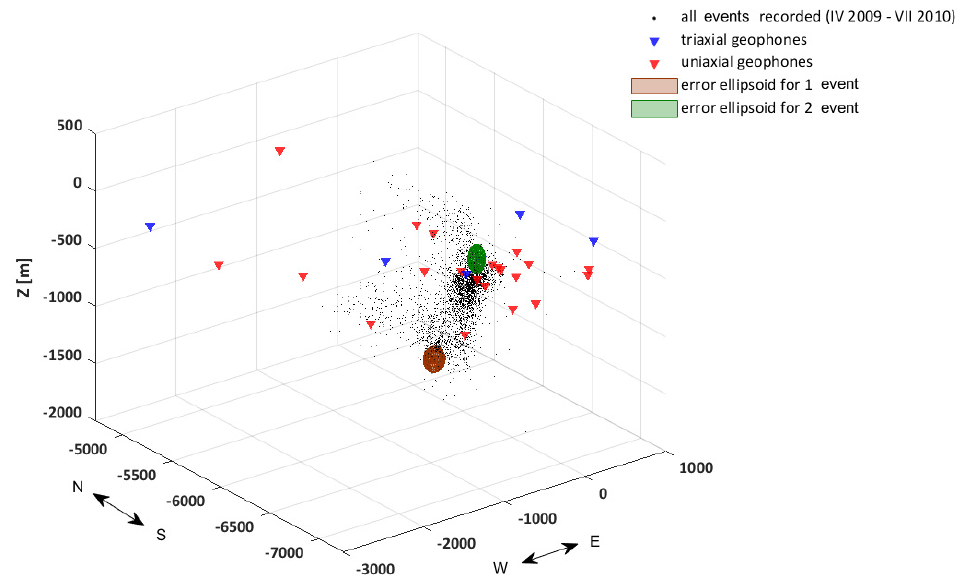
Figure 4. The seismic network of the Bobrek mine with events registered between April 2009 and July 2010. Uniaxial geophones are marked with red triangles and triaxial geophones with blue triangles.